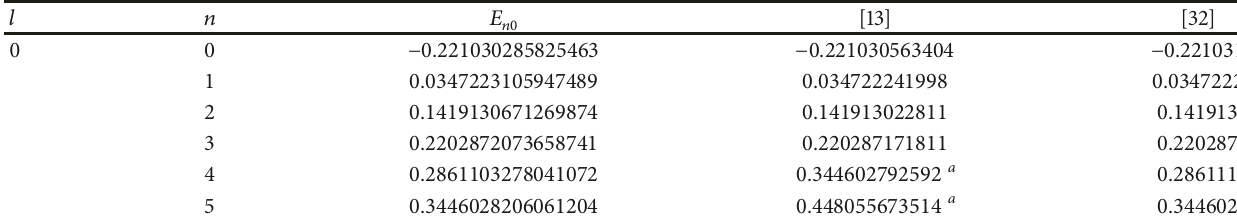
Table 3: Comparison of eigenvalues of 𝑉(𝑟) = −1/𝑟 + 0.01𝑟 for 𝑛 states.